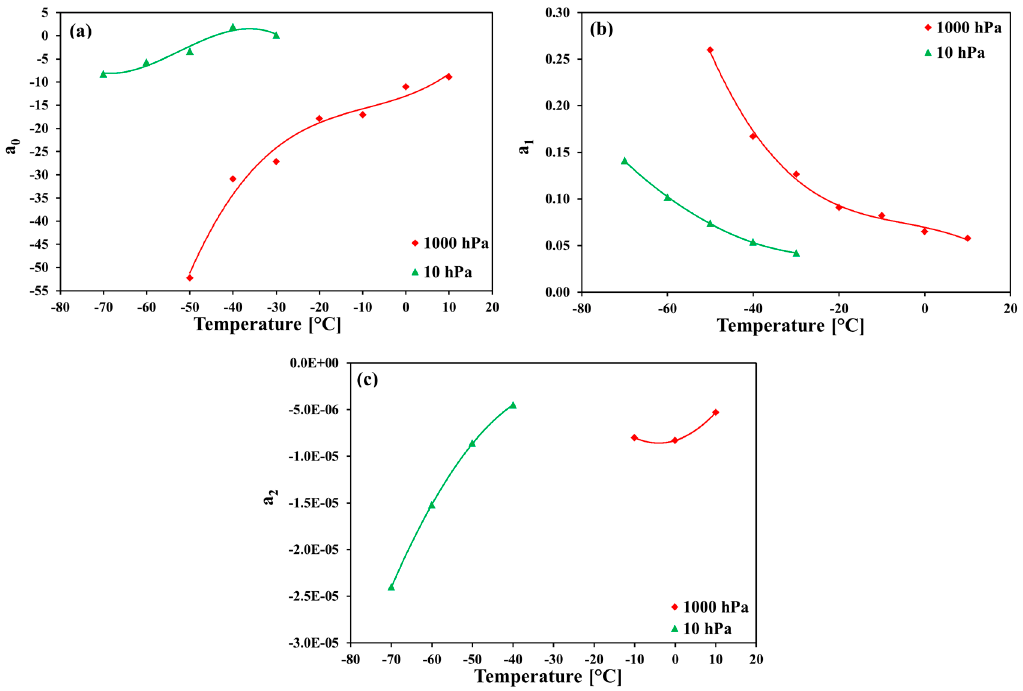
Figure 3. Temperature dependencies of the parameters a 0 , a 1 , and a 2 at pressures 1000 hPa and 10 hPa (on the basis of the values from Table 2). Table 3. Polynomial regression fit equations of the curves shown in Figure